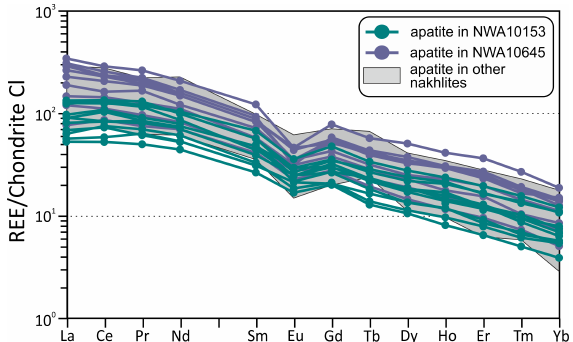
Figure 5. Chondrite-normalized [51] REE distribution patterns for apatites of from the NWA 10153 and NWA 10645 meteorites. For comparison, the REE patterns are from other reported apatite in nakhlites after Wadhwa and Crozaz [52], Terada and Sano [53], and Wadhwa et al. [54] are shown.